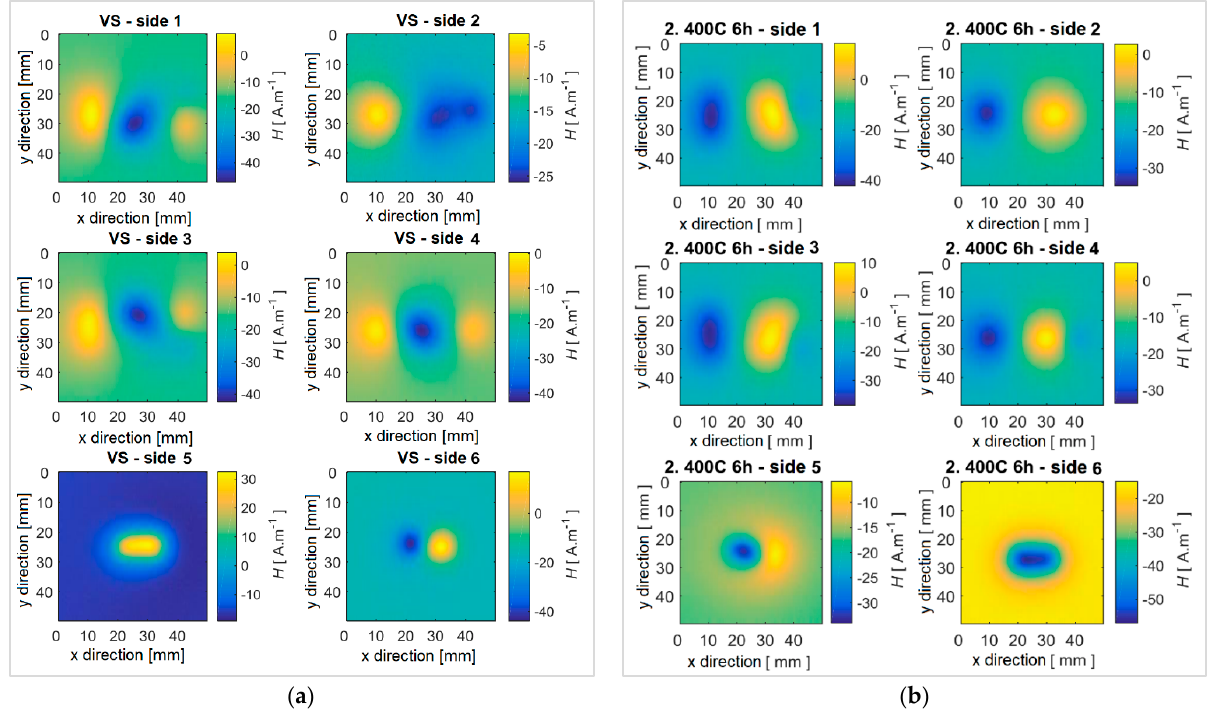
Figure 8. Distribution of the magnetic field of the specimen ( a ) No. 1 and ( b ) No. 2.